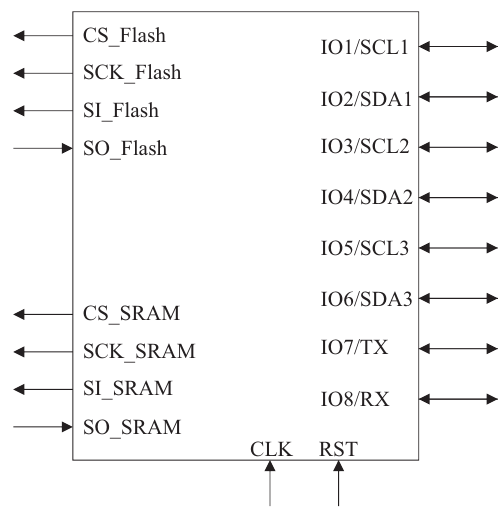
Figure 22. PAMPIUM IC input and output